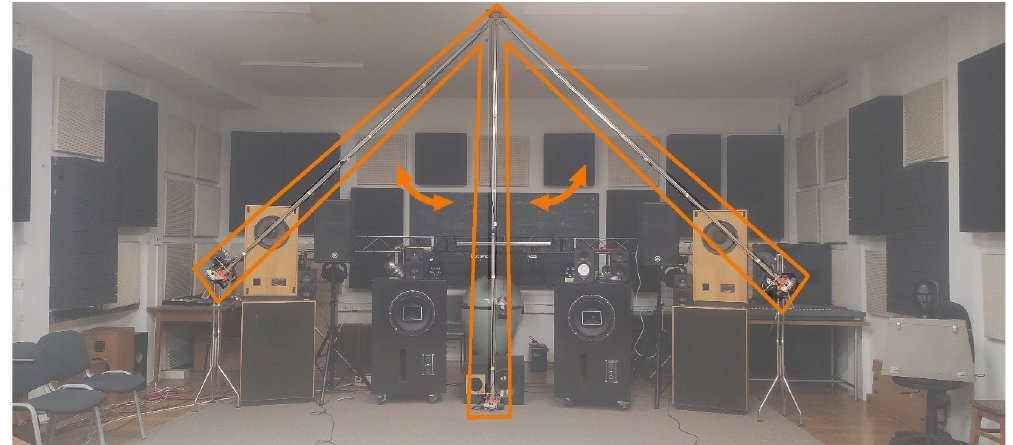
Figure 12. Measurement setup based on the gravity pendulum. Maximum displacement positions on both sides and the equilibrium position in the middle are marked.